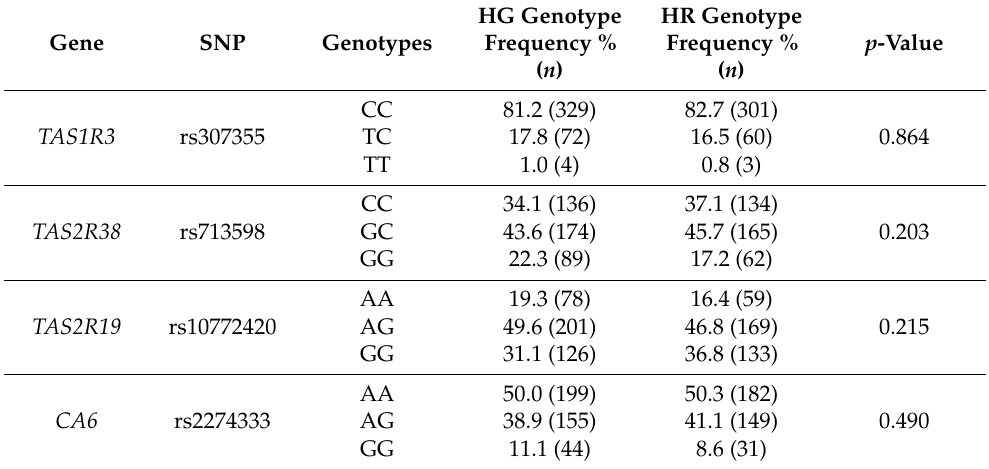
Table 2. Genotype frequencies of selected genetic polymorphisms in the Hungarian general and Roma